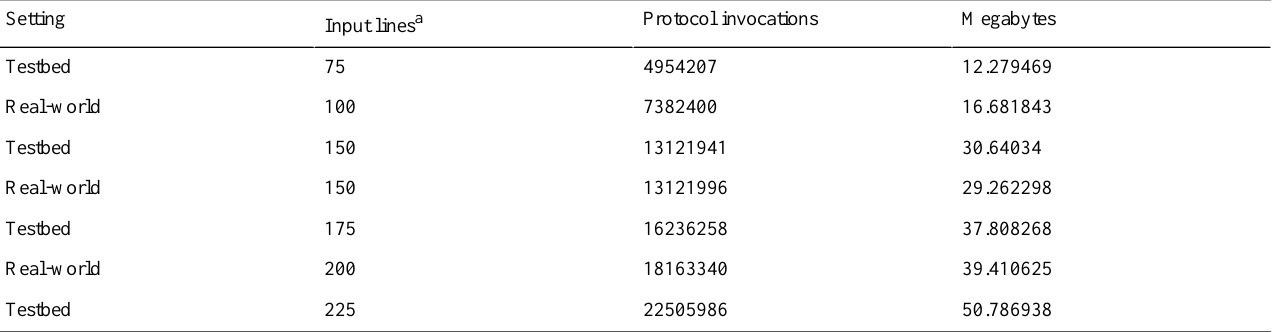
MegabytesProtocol invocationsInput lines a Setting